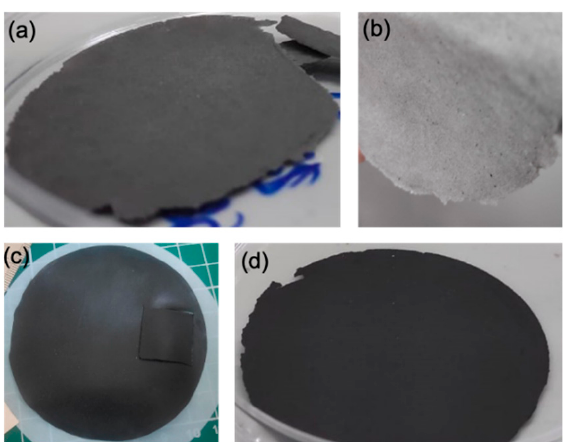
Figure 3. Digital photographs of nanocomposite films. Images of MCC-1%CB ( a ), CP-0.05%CNT ( b ), CNF-1%CB ( c ) and MCC-5%CNT ( d ).